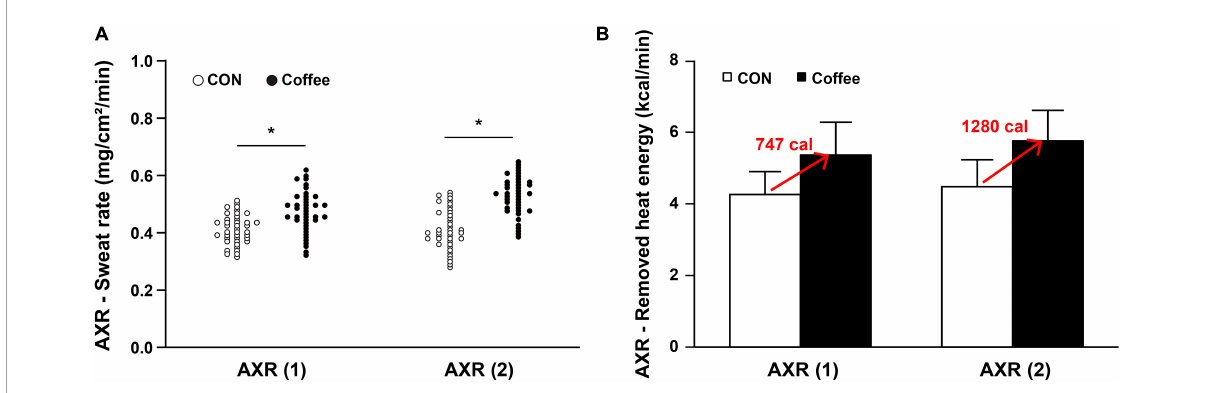
FIGURE2 (A) Comparison of sweating activity between subjects in CON and Coffee groups at axon reflex (AXR) (1) and AXR (2). (B) Comparison of estimated value on remove heat energy of whole body between CON and Coffee groups at AXR (1) and AXR (2). AXR (1) = 0–5 min and AXR (2) = 6–11 min. Values are means + SD. Statistical significance difference, * p < 0.05. CON, no coffee group ( n = 40); Coffee, coffee intake group ( n = 40); AXR, axon reflex mediated; AXR (1), AXR sweating during 5 min 10% acetylcholine (ACh) iontophoresis; AXR (2), AXR sweating during 5 min post-iontophoresis.